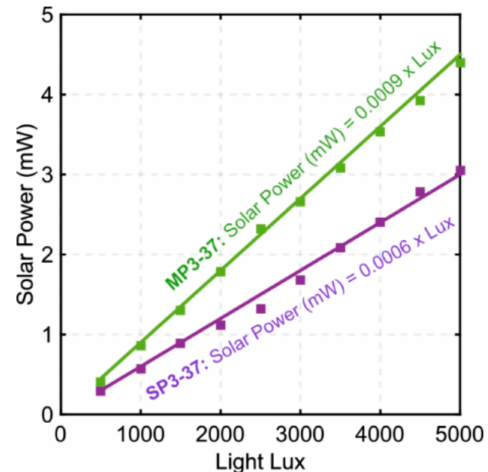
Figure 10. Experimentally measured power from a single solar panel in milli-Watt versus light lux. Markers represent the experimentally measured values whereas lines represent curve fitting for the measured